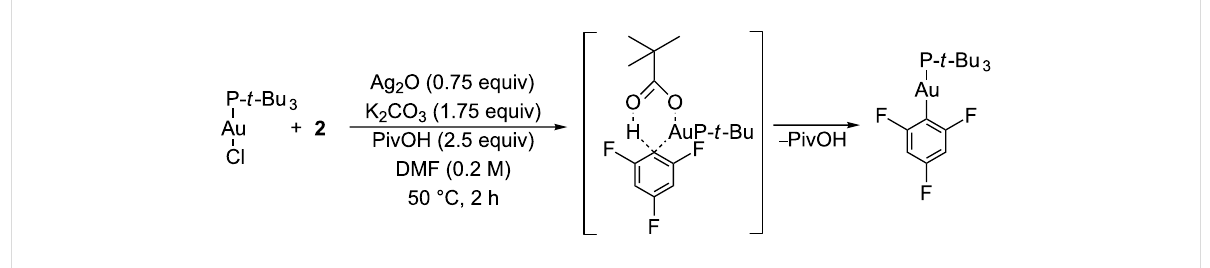
Scheme 2: C–H functionalisation of 2 using gold-phosphine complexes and a silver additive.